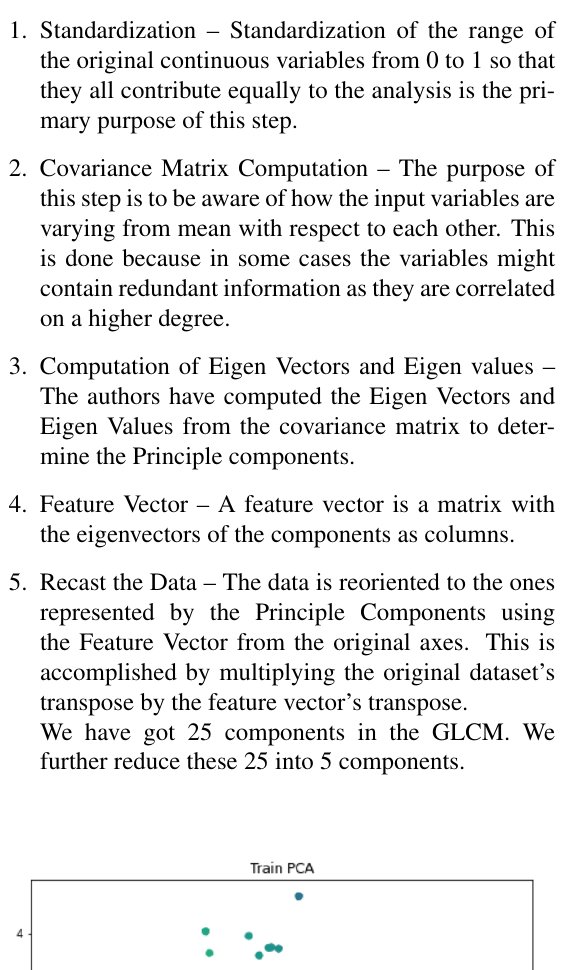
Figure 7. Test PCA